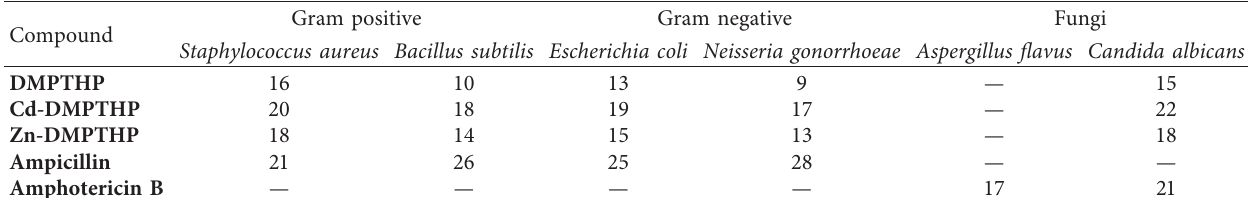
Table 4: Antibacterial and antifungal activities of the synthesized compounds.